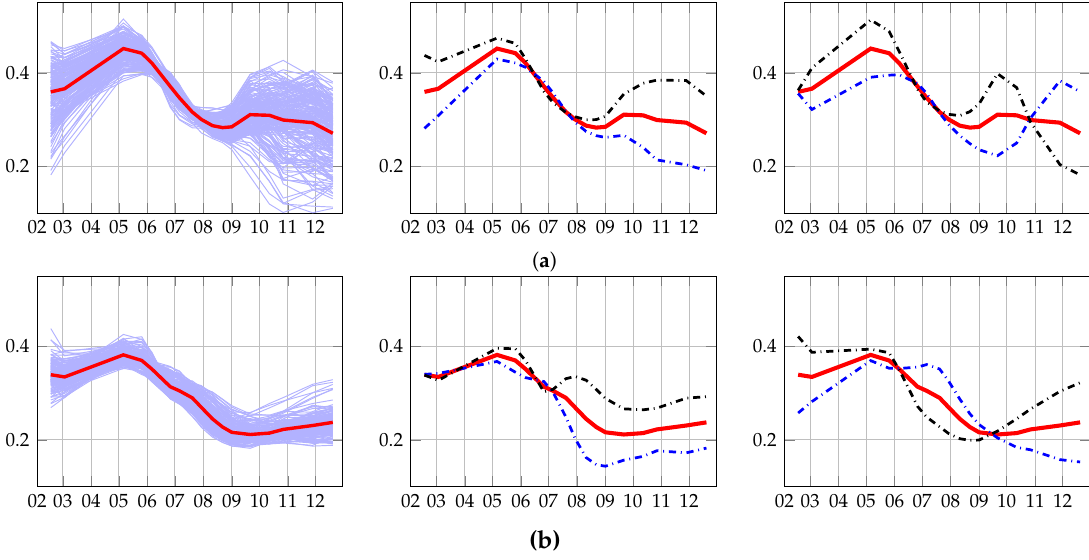
Figure 7. Examples of 2013 time series evolution in the NIR reflectance band of Formosat-2 for a grassland of management practice ( a ) "mowing" and ( b ) "grazing". The x-axis is the month of the year. The y-axis is the NIR reflectance value. The plot on the left shows the evolution of all the pixels in the grassland and the temporal mean of these pixels in red. The plot in the middle shows the temporal mean in red, the temporal mean + 0.2 the first eigenvector in blue and the temporal mean 0.2 the × − × first eigenvector in black. The plot on the right shows the temporal mean in red, the temporal mean + 0.2 the second eigenvector in blue and the temporal mean 0.2 the second eigenvector in black. × − ×